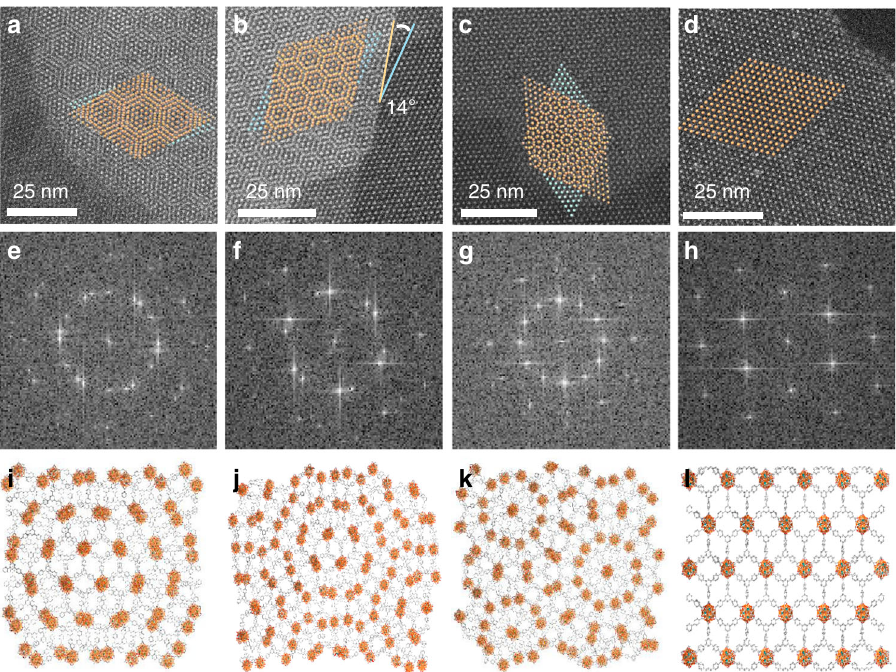
Fig. 2 Morphology and Structural Simulation of 2-D twisted and untwisted Zr-BTB-FA nanosheets. HAADF images ( a – d ), FFT images ( e – h ) and simulated structures ( i – l ) of double layers with the rotation of 8° ( a , e , i ), double layers with the rotation of 14° ( b , f , j ) and double layers with the rotation of 30° ( c , g , k ), multilayers with the rotation of 0° ( d , h , l